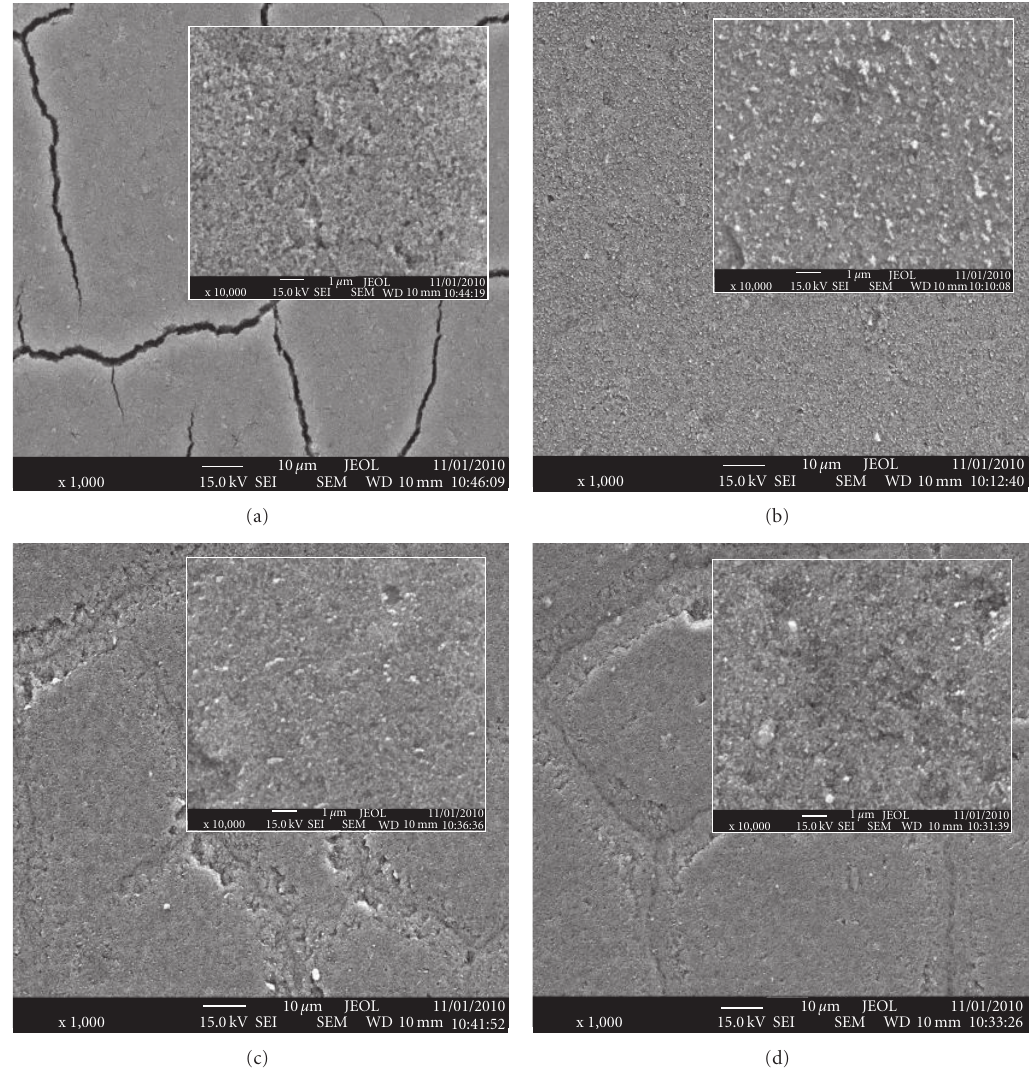
Figure 3: SEM pictures of films after various CIP processes. (a) film without CIP; (b) film with a CIP pressure of 50MPa and holding time 1s; (c) film with a CIP pressure of 100 MPa and holding time 600 s; (d) film with a CIP pressure of 200 MPa and holding time 600 s. The small inset shows the higher magnifications of each sample. The mark bar for the inset is 1 μ